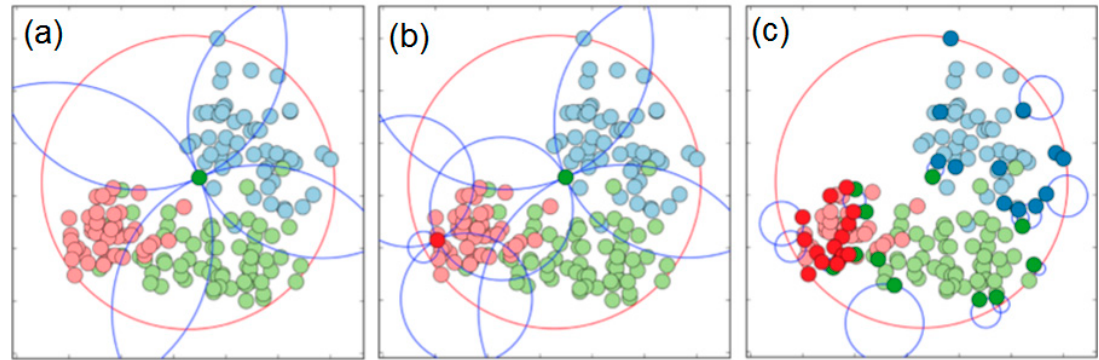
Figure 13. Incremental prototype selection algorithm with circular domain (Wine dataset): ( a ) after the first iteration; ( b ) after the second iteration; ( c ) after the last iteration. Colored balls are data samples from the dataset and those bolder ones are from the set of already selected prototypes. Domain boundary is shown as a red circle and the blue circles are the voids, from which the ignorance zones are computed.